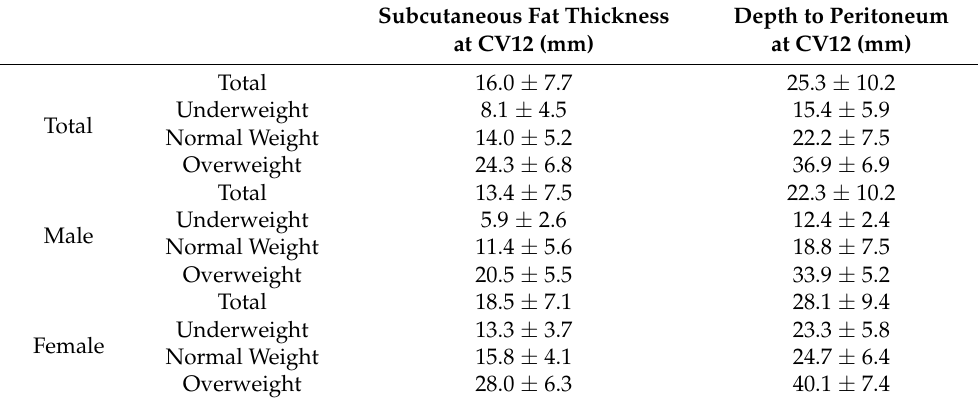
28.1 mm. Table 2 indicates the average thickness of subcutaneous fat at acupoint CV12 and the average depth of skin to peritoneum at acupoint CV12 Table 2. Depth to subcutaneous fat and peritoneum on acupoint CV12.